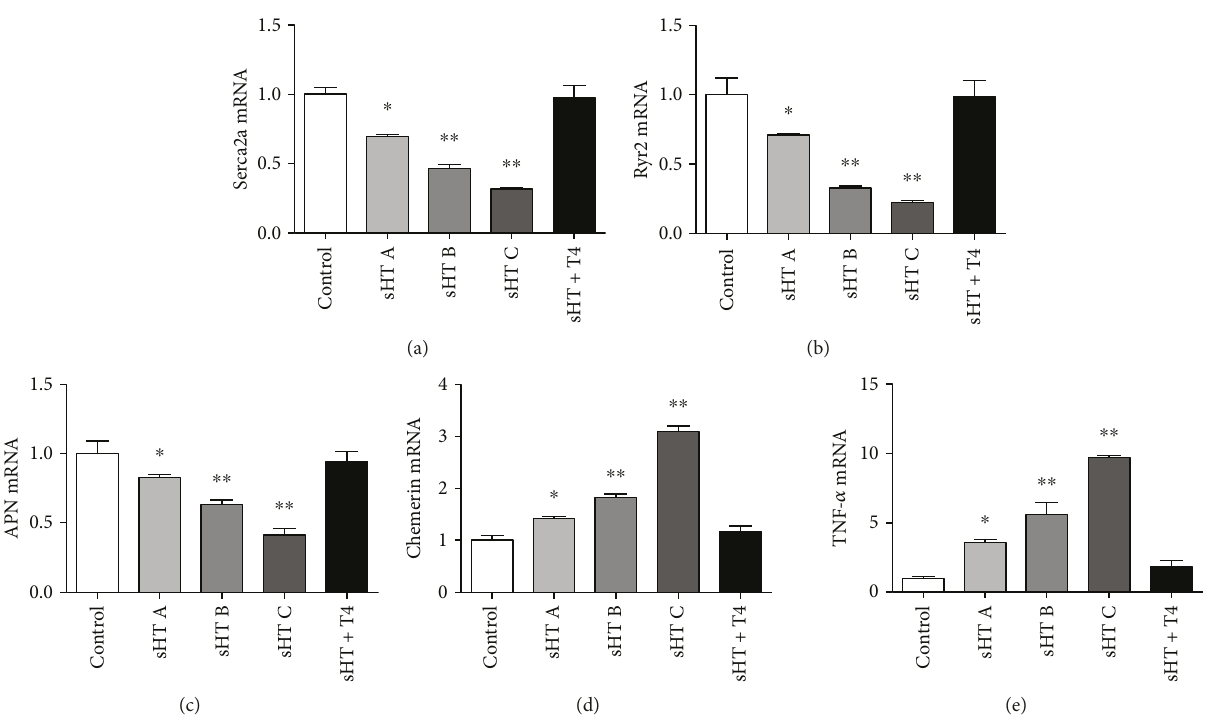
Figure 2: The expression of serca2a, Ryr2, APN, chemerin, and TNF- α mRNA in the cardiac muscle tissue was measured with real-time PCR. ∗∗ p < 0 001 and ∗ p < 0 05